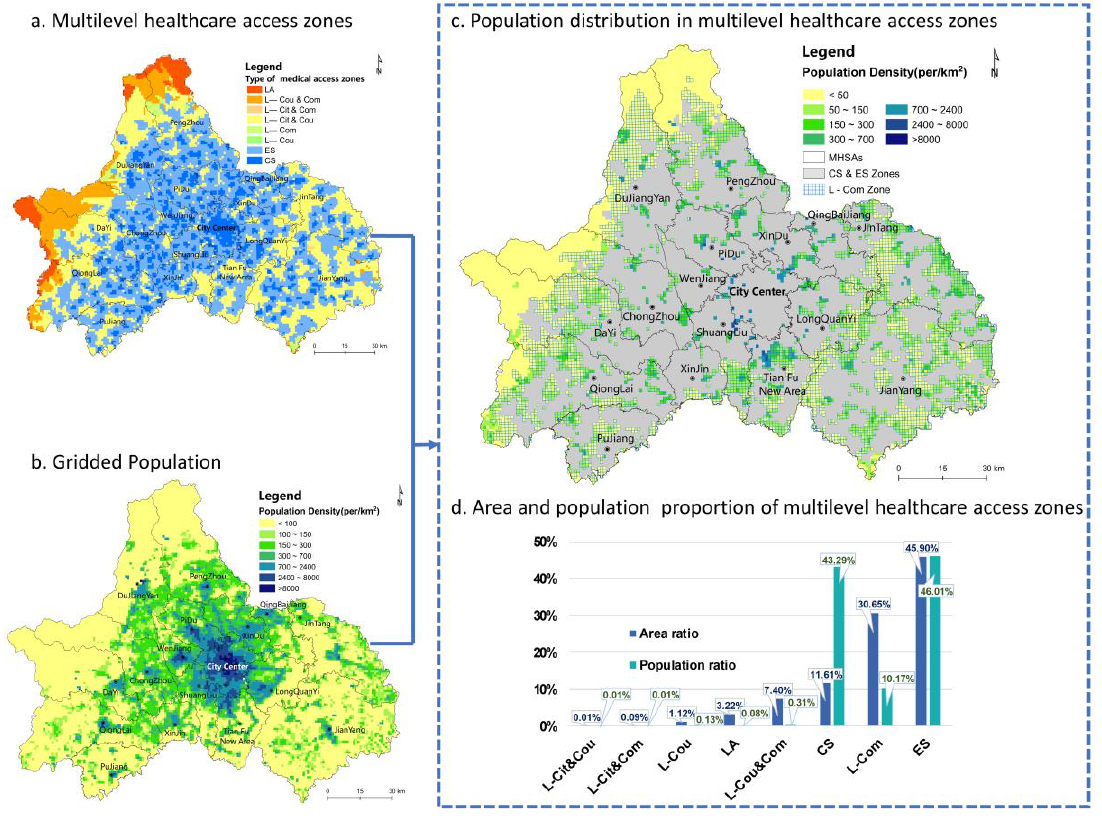
Figure 6. Multilevel healthcare spatial equity.